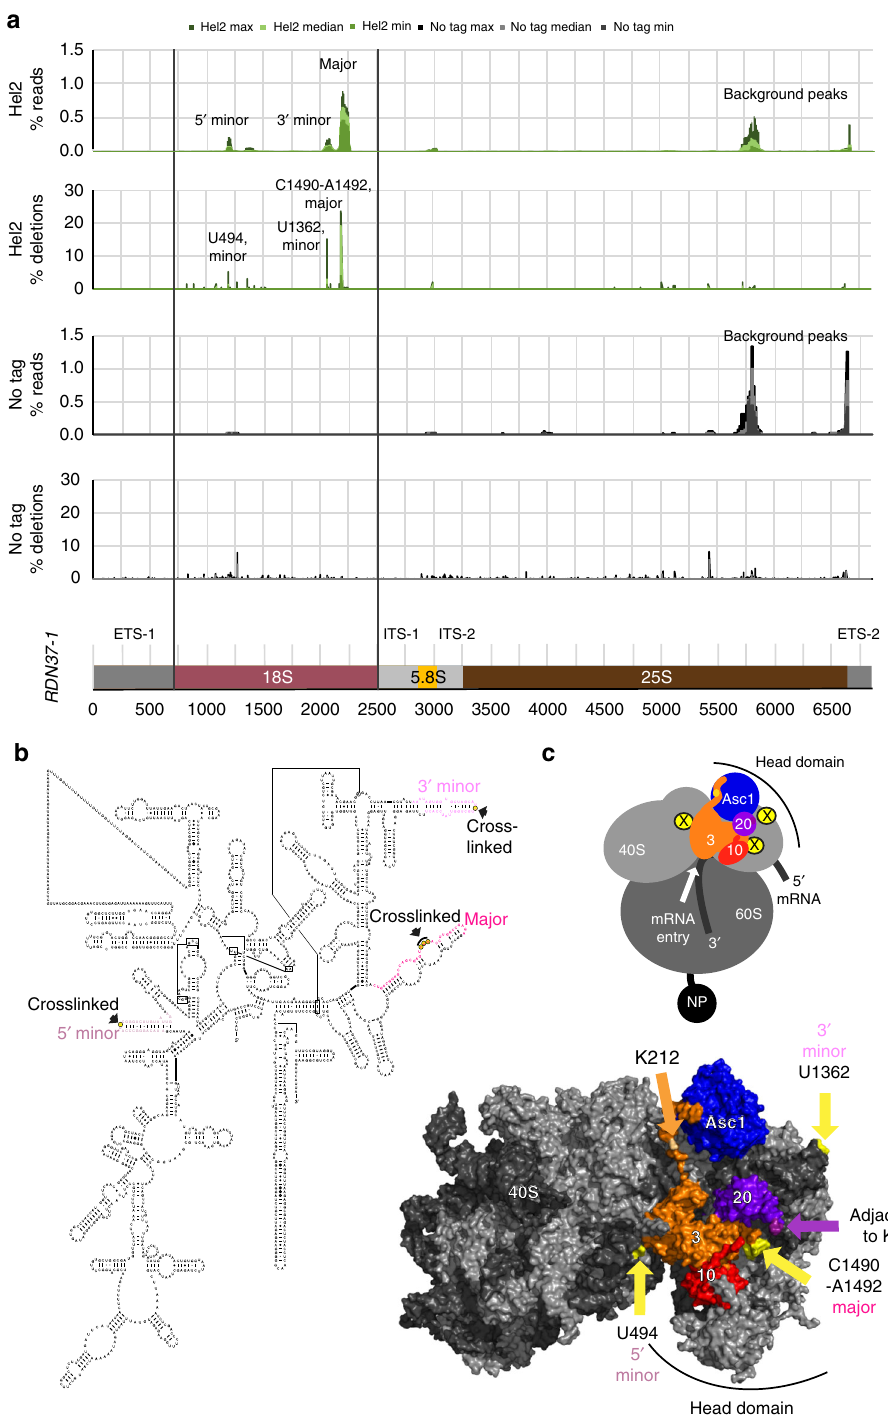
Fig. 3 Hel2 ribosomal crosslinking sites. a Hel2 and untagged crosslinking and analysis of cDNA (CRAC) data aligned to RDN37-1 showing reads ( fi rst and third panel) and deletions (second and fourth panel) all normalized to total reads/deletions in RDN37-1 ( fi fth panel). ETS external transcribed spacer, ITS internal transcribed spacer. b 18S rRNA secondary structure according to Comparative RNA Website (CRW) 40 with stem-loop structures enriched in Hel2 CRAC highlighted in different shades of pink and crosslinked nucleotides (high-frequency micro-deletions in Hel2 CRAC) highlighted in yellow. c Crosslink sites (high frequency deletions in Hel2 CRAC) highlighted on a 3D structure representation of the S. cerevisiae ribosome. Top panel: schematic model showing the locations of the nascent peptide position and crosslinks (major: X , minor: x). Lower panel: crystal structure 41 ; pdb 4v88, 40S subunit of monosome chain B is shown) with crosslinked nucleotides highlighted in yellow and further indicated by yellow arrows. In both panels, speci fi c ribosomal proteins are indicated: Asc1 (dark blue), Rps3 (orange), Rps10 (red), Rps20 (violet). Other ribosomal proteins are shown in lighter grey, with rRNA in darker grey. Ubiquitination target sites are indicated by coloured arrows; violet for Rps20 (K6) (adjacent site shown, since the actual amino acid is not part of the crystal structure) and orange for Rps3